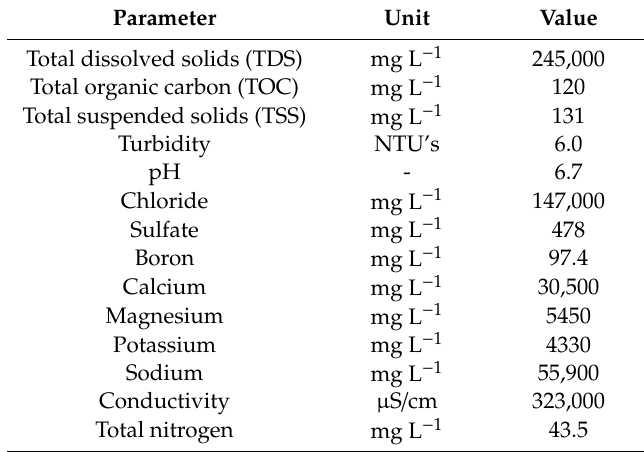
Table 1. Produced water (PW) analysis indicating main